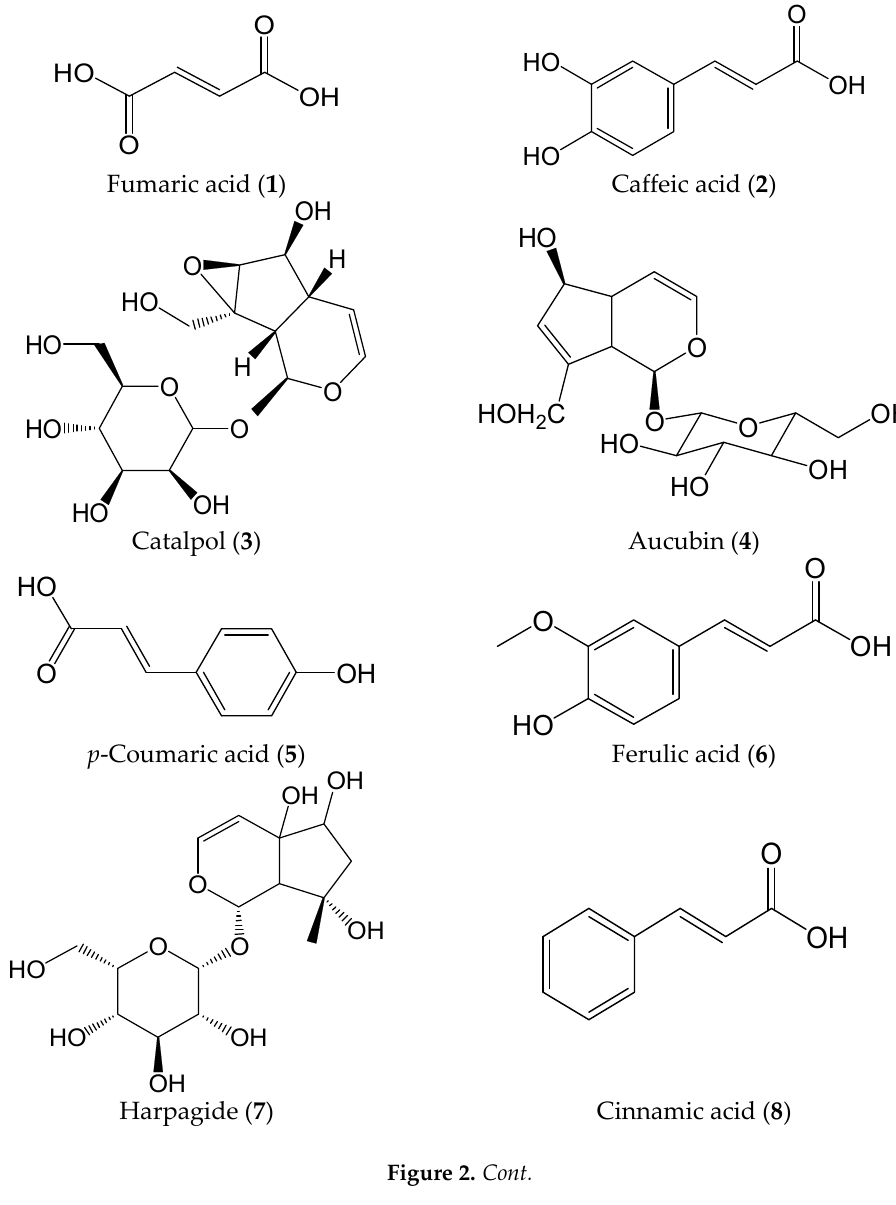
Figure 2. Cont. Figure 2.